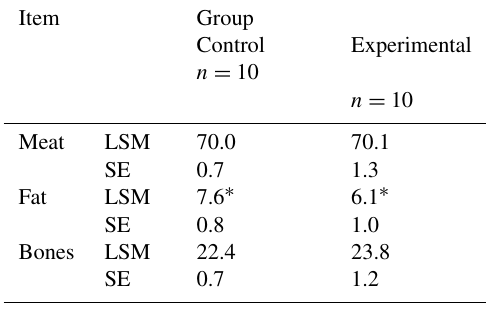
Table 4. Percent tissue composition in the goat legs